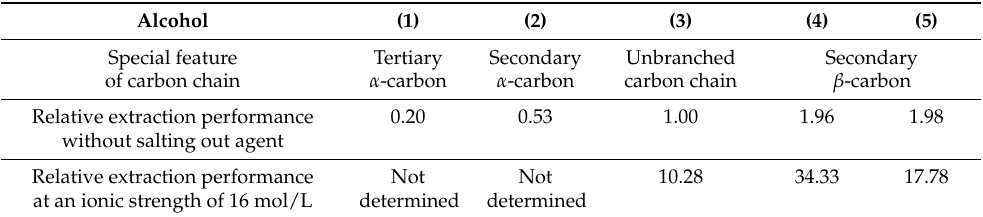
Table 3. Correlation between the structure of the carbon chain and the relative extraction performance of monohydric alcohols calculated with D ROH /D n -octanol (3,7-dimethyl-3-octanol (1) , 2-octanol (2) , n - octanol (3) , 2-ethyl-1-hexanol (4) , and 2-butyl-1-octanol (5) ). Alcohol Special feature Tertiary Secondary Unbranched Secondary of carbon chain α